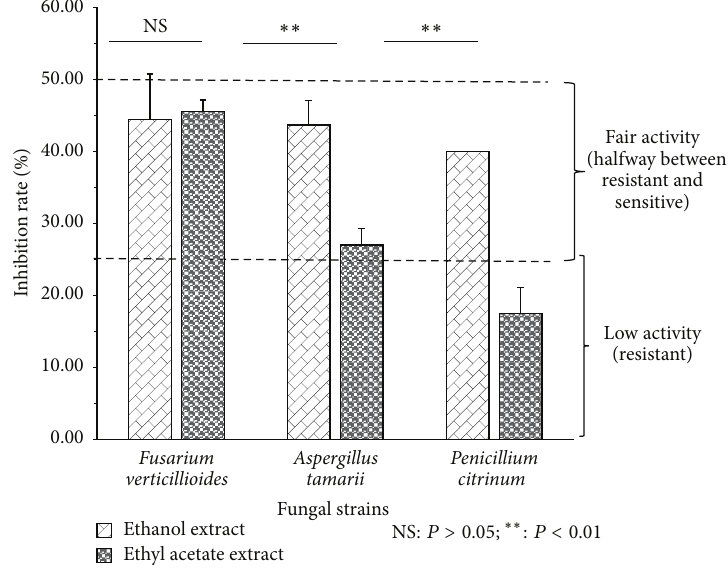
Figure 4: Inhibition rate of Cola nitida ’s extracts in the fungal